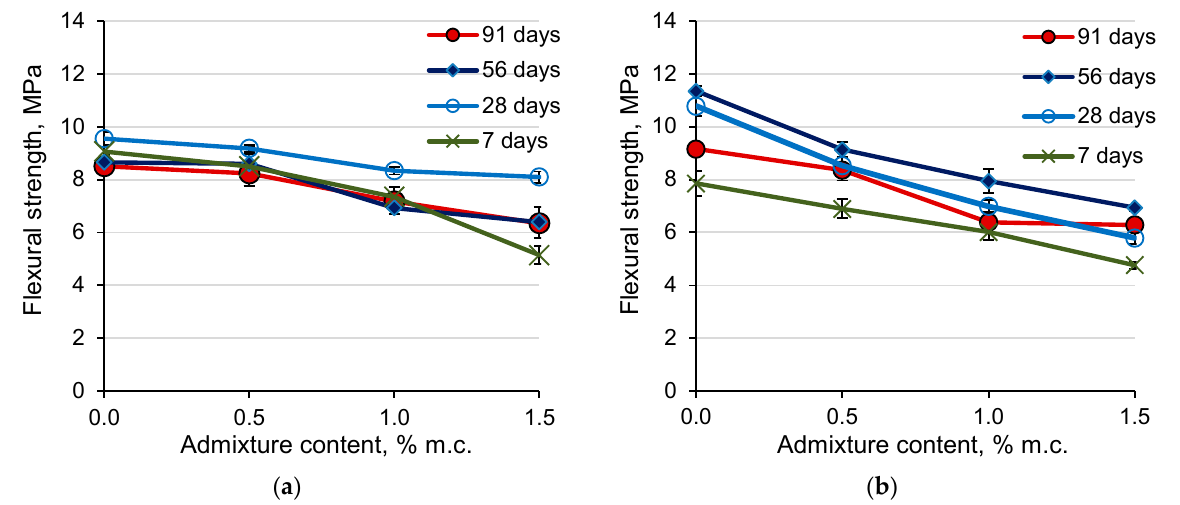
Figure 7. The effect of the admixture containing aluminum on the flexural strength of mortars with ( a ) CEM I cement, ( b ) CEM III cement.